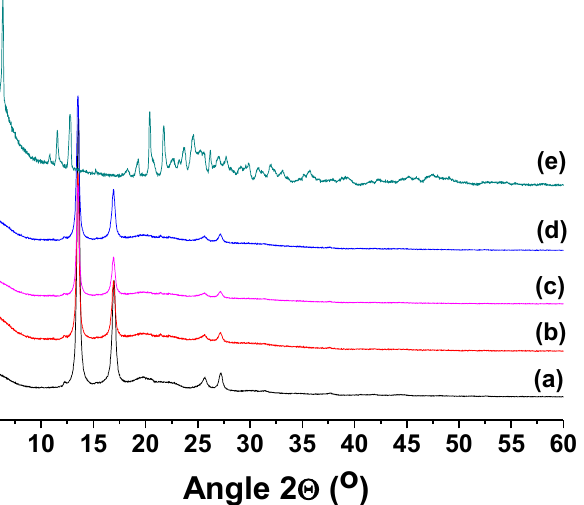
Figure 6. XRD patterns of: ( a ) PHB mat; ( b ) PVP in PHB mat; ( c ) PVP,CQ in PHB mat; ( d ) PVP,CQ on PHB mat; and ( e ) CQ powder.